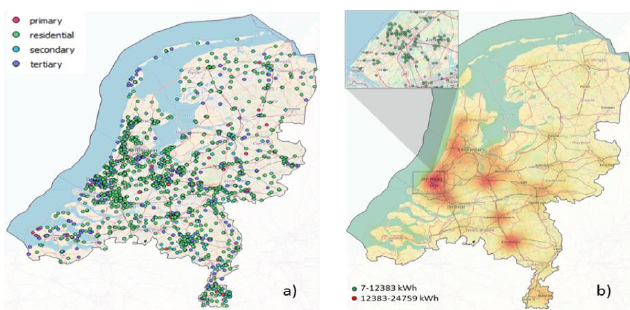
Figure 2. ( a ) Chargers’ location by road segment and ( b ) heat map of energy demand during the total timespan under analysis (radius 10 mm).